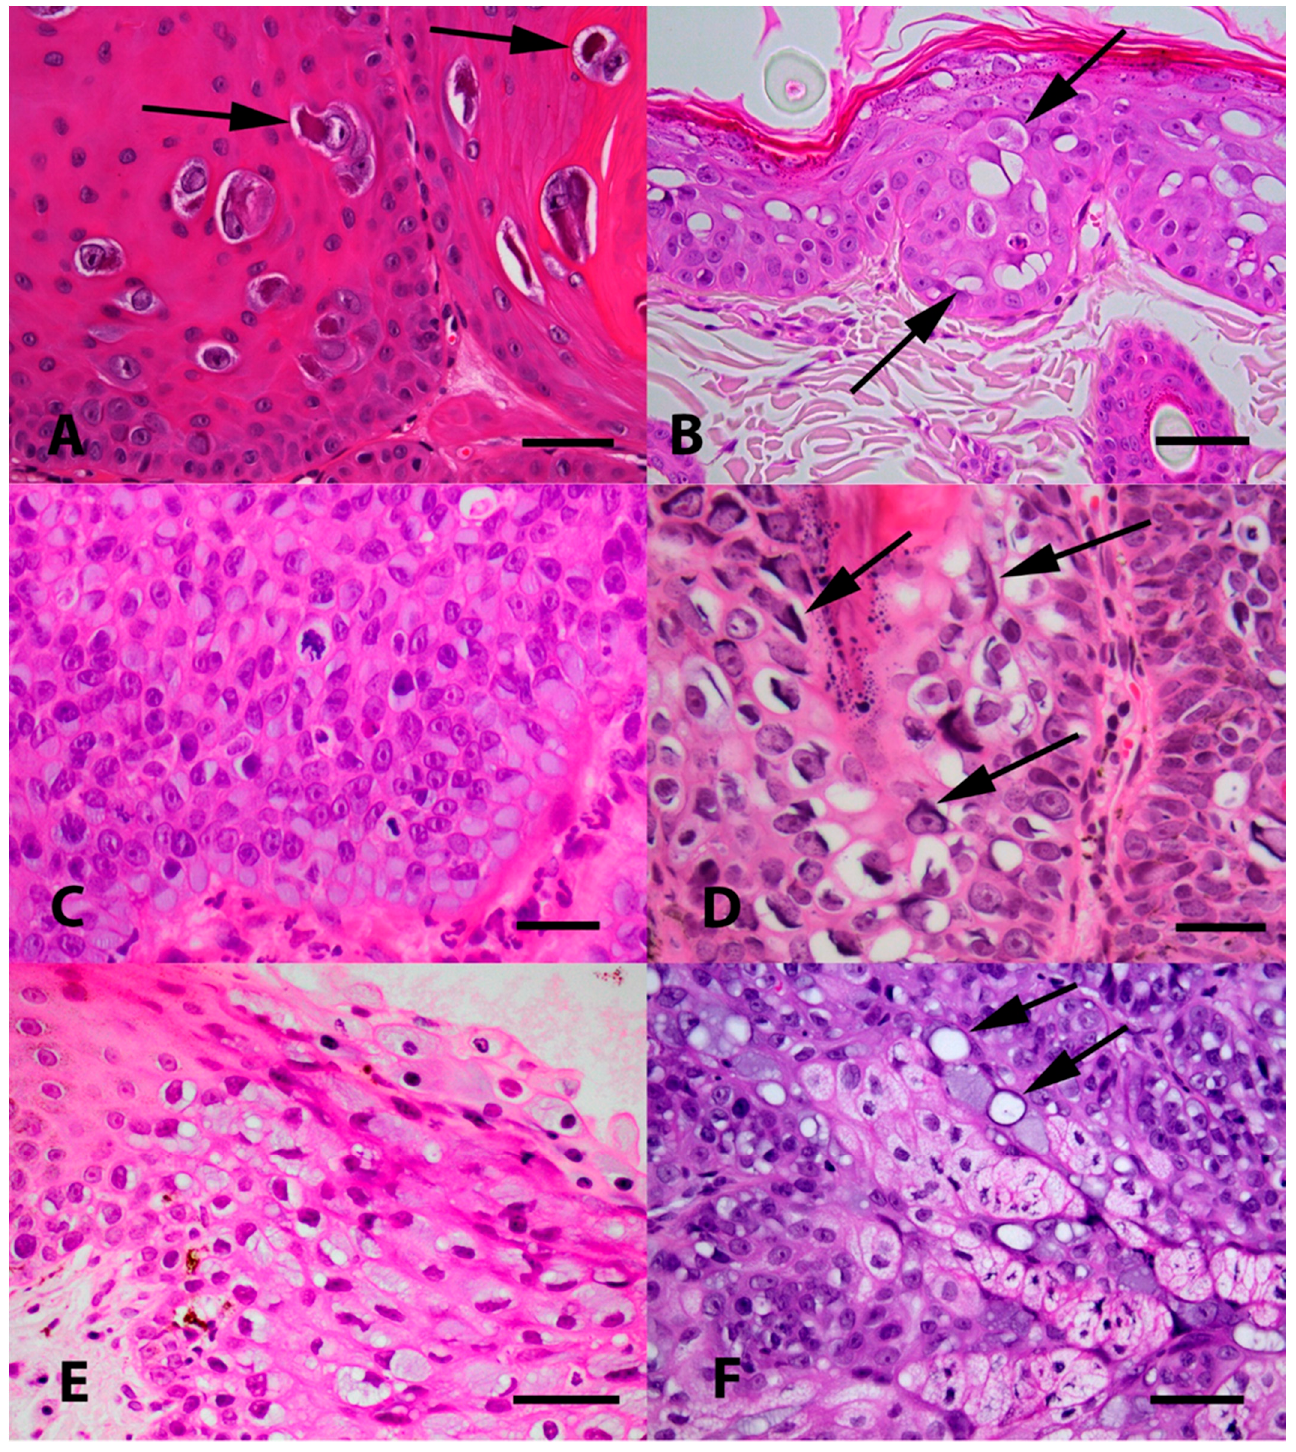
Figure 2. ( A ) Photomicrograph of an oral papilloma caused by Felis catus papillomavirus type 1 (FcaPV1). Infection of cells by this papillomavirus (PV) tends to result in the presence of a relatively small proportion of cells developing expanded cytoplasm and nuclei. Within the nuclei, the chromatin becomes compressed peripherally with the presence of a prominent nucleoli. However, the most characteristic feature of FcaPV1 is the development of large prominent eosinophilic cytoplasmic bodies within the expanded cytoplasm (arrows). HE Bar = 30 µm. ( B ) Photomicrograph of an early Bowenoid in situ carcinoma caused by FcaPV2. Infected cells have expanded cytoplasm that is wispy and blue/grey or clear (arrows). Nuclei are enlarged, but do not have the central chromatin clearing as is visible within cells infected by FcaPV1. Cells within deeper layers of the epidermis have dark shrunken nuclei that are surrounded by a clear halo (koilocytosis). HE Bar = 22 µm. ( C ) Photomicrograph of a more advanced Bowenoid in situ carcinoma caused by FcaPV2. Many